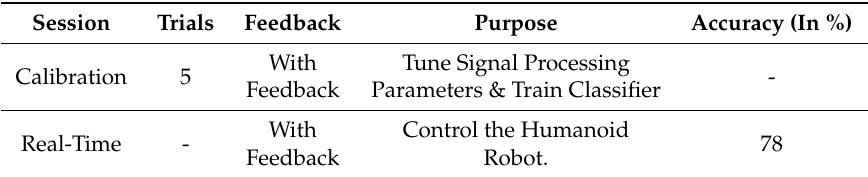
Table 4. Experiment sessions used in [68].